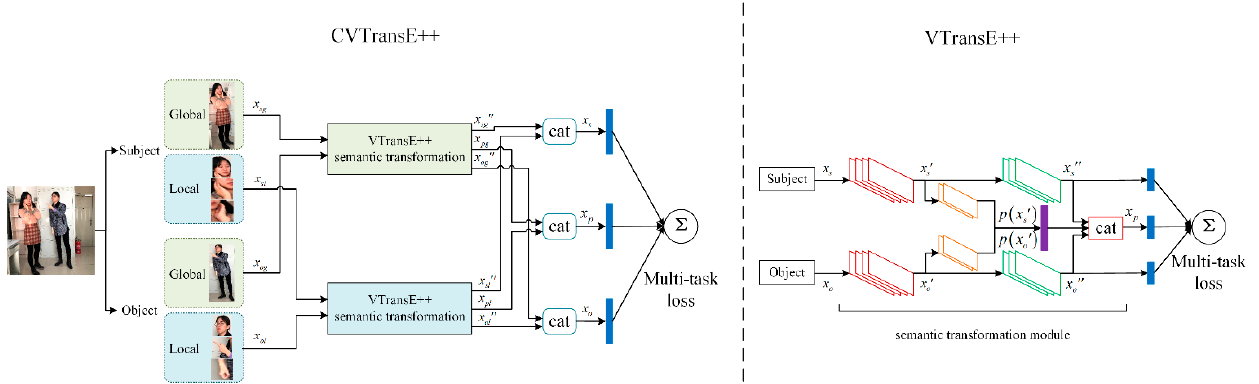
Figure 6. DVtransE++ is the optimized relationship model, and the Co-operative Visual Translation Embedding++ network (CVtransE++) is the feature fusion-based model finally proposed in this paper. “VTransE++ semantic transformation” in CVtransE++ is the semantic transformation module in VTransE++.